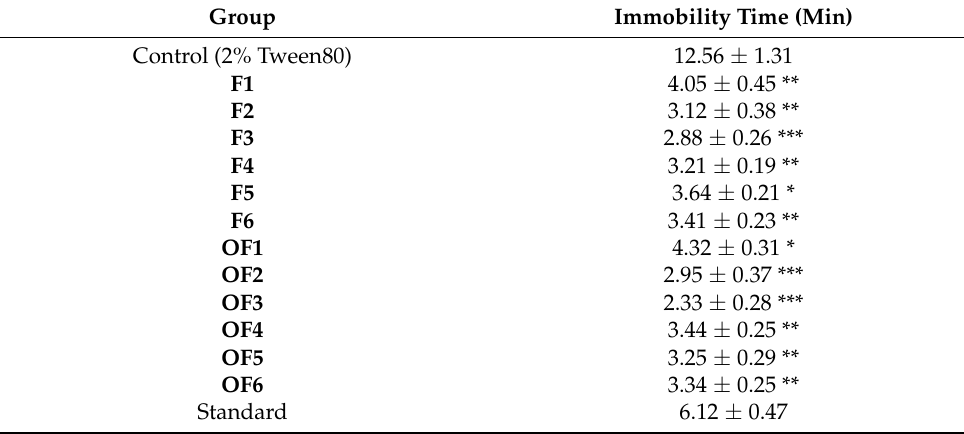
Table 2. Effect of flavonoids on swimming endurance